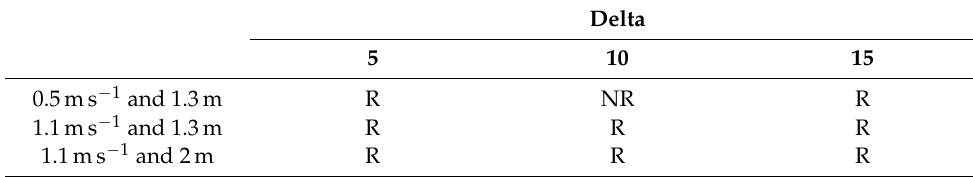
Table 6. Student’s t -test for frontal